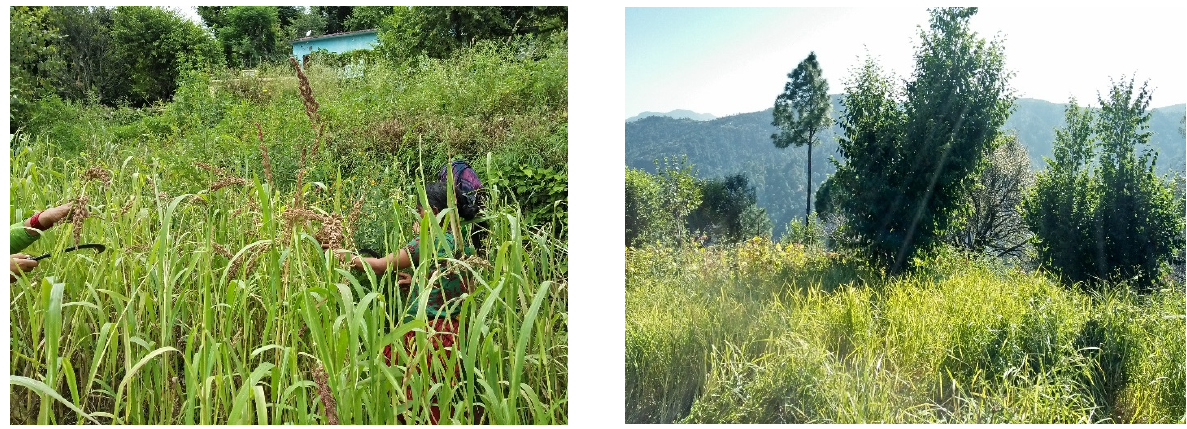
Figure 3. Cultivation of E. frumentaceae and E. coracana under G. oppositifolia -based traditional agroforestry system in Garhwal Himalaya.